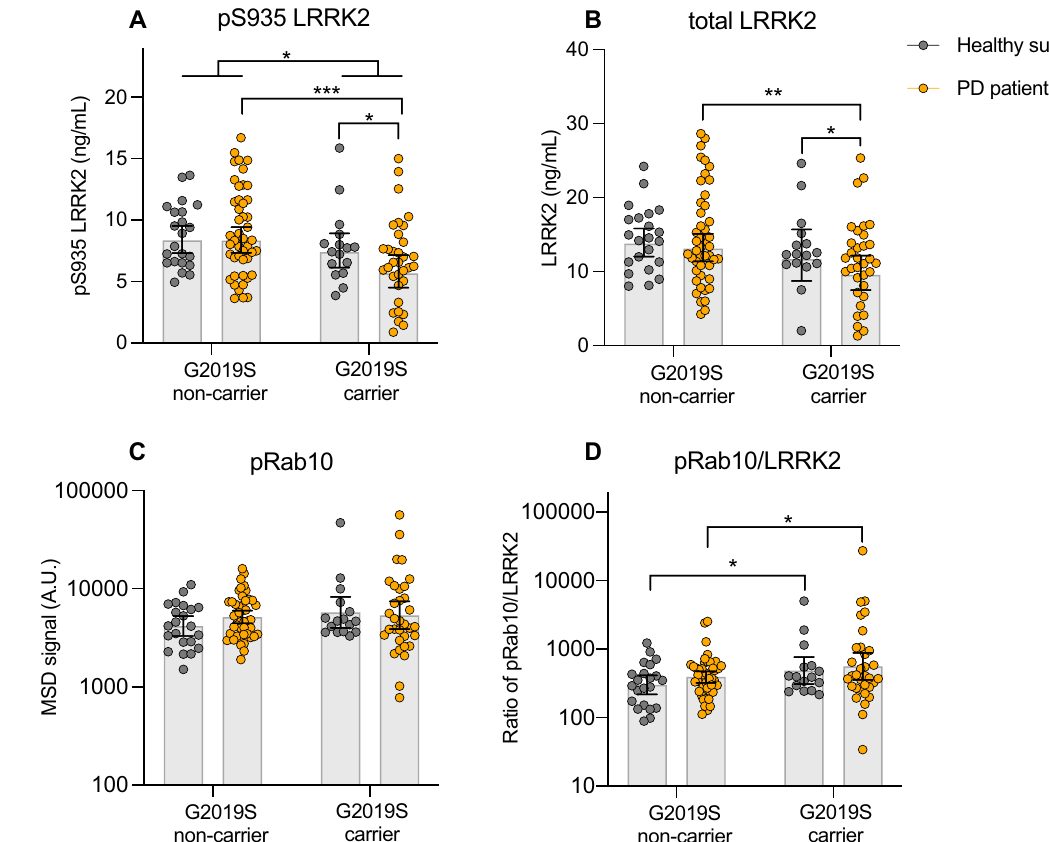
Figure 5. LRRK2 and pT73 Rab10 levels assessed in PD patients and healthy subjects. LRRK2 levels and activities were measured in PBMCs from PD patients and healthy subjects with and without LRRK2 G2019S variant provided by the LRRK2 Detection in PBMC Consortium 32 ; n = 16 non-PD-LRRK2 G2019S carriers, n = 22 non-PD non-G2019S carriers, n = 46 PD non-G2019S carriers, n = 33 PD and G2019S carriers. pS935 and total LRRK2 levels were shown as ng/ml and were calculated based on a standard curve of recombinant LRRK2 protein that was analyzed along with the PBMC lysates as in-plate reference material. For each variable, an ANCOVA model was fit, with log2 (value) as response and terms for Cohort, G2019S status (and their interaction), Gender and Age. For each variable, a forward model selection step was performed to assess the usefulness of adjusting for Age or including an interaction term; p values were based on pairwise comparison between groups. ( A ) For pS935 LRRK2, p = 0.0002 between G2019S carriers and non-carriers in PD (Relative Geometric mean ± 95% confidence interval = 0.651 (0.524–0.810)); p = 0.0134 between PD and non-PD in G2019S carriers (relative geometric mean ± 95% confidence interval = 0.673 (0.492–0.920)); p = 0.0233 between G2019S carriers and non-carriers (Relative Geometric mean ± 95% confidence interval = 0.805 (0.660–0.970)). ( B ) For LRRK2, p = 0.0028 between G2019S carriers and non-carriers in PD (relative geometric mean ± 95% confidence interval = 0.688 (0.540–0.877)); p = 0.0396 between PD and non-PD in G2019S carriers (relative geometric mean ± 95% confidence interval = 0.693 (0.489–0.982)). ( C , D ) For pT73 Rab10/LRRK2, p = 0.0171 between G2019S carriers and non-carriers in PD and in non-PD (relative geometric mean ± 95% confidence interval = 1.44 (1.07–1.95)). Relative geometric means given are adjusted for age and sex. Data are shown as geometric mean ± 95% confidence interval (CI). *p ≤ 0.05, **p ≤ 0.01, ***p ≤